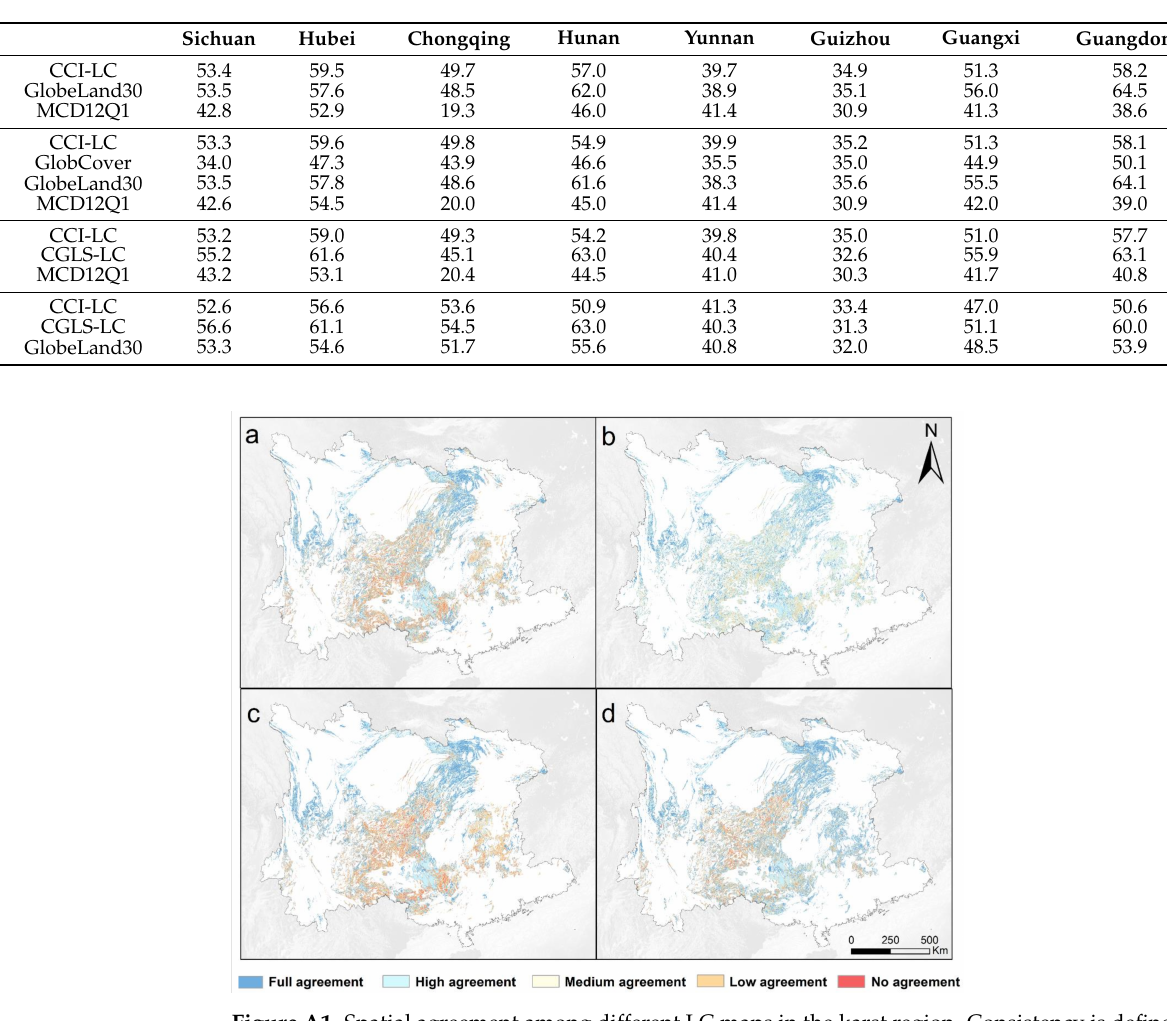
Table A2. Overall accuracy of land cover datasets by province (unit: %).